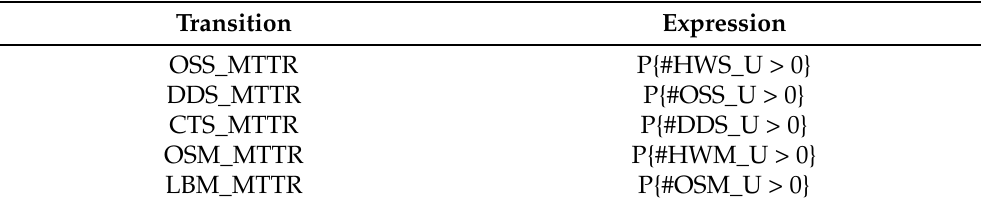
Table 5. Guard conditions used to guarantee components